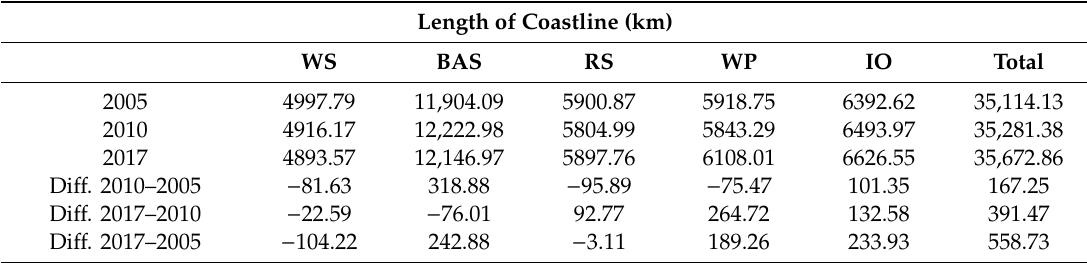
Figure 5. Coastline contours from the present algorithm for 2005, 2010, and 2017 (blue, green, and red, respectively). The deviation between the contours is very small ( < 10 km) in most locations, but the insets highlight the nine areas with highest deviation between 2005 and 2017. Table 5. Change of coastline length in each sector (km) during 2005–2017.